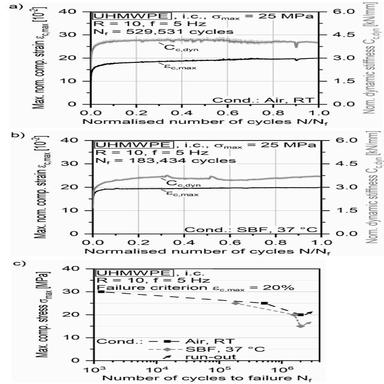
Results of the experimental fatigue tests on UHMWPE: a) Constant amplitude test (CAT) at σ max ¼ 25 MPa in air at room temperature (RT), b) CAT at σmax ¼ 25 MPa in simulated body fluid (SBF) at 37 �C, c) Summarised results of CAT to an approximated Woehler curve in semi-logarithmic application for both conditions.